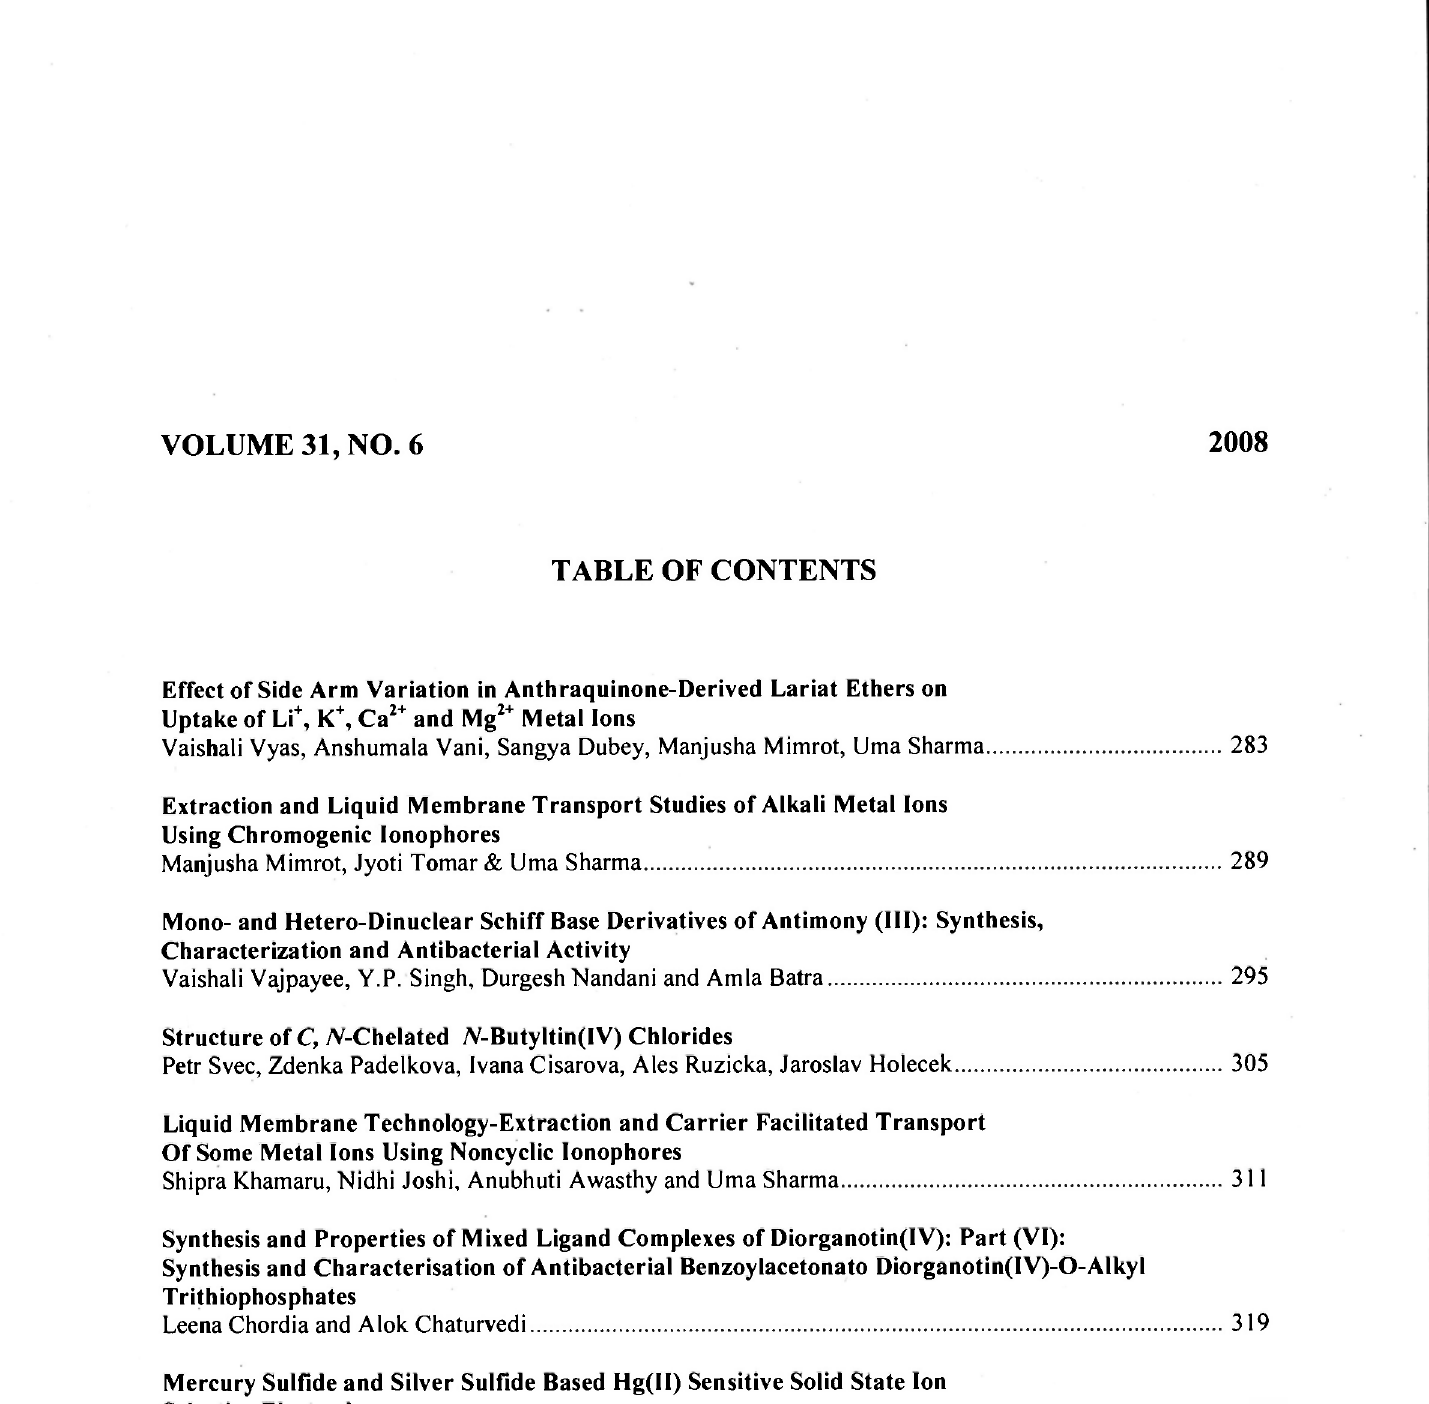
Extraction and Liquid Membrane Transport Studies of Alkali Metal Ions Using Chromogenic